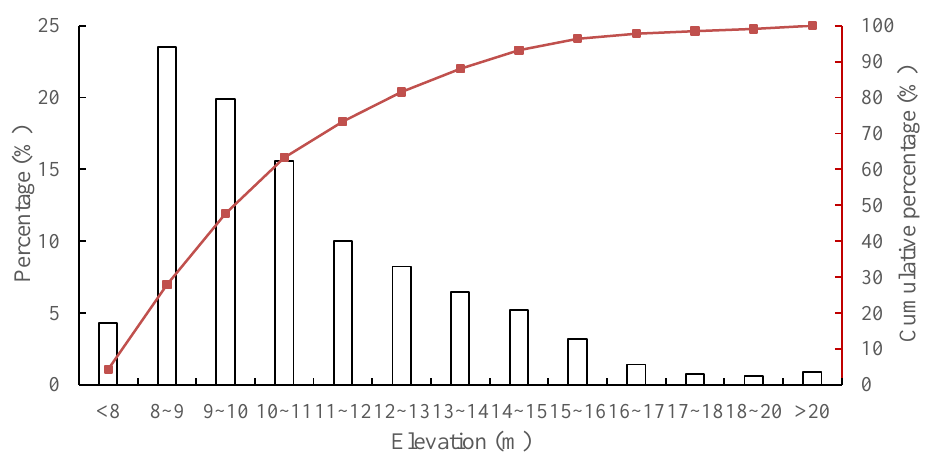
Figure 8. Bottom topographic map of Poyang Lake derived from the proposed method.